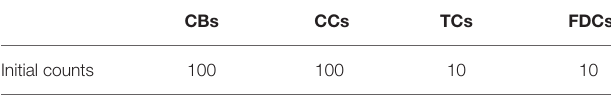
TABLE 2 | Initial conditions used in model simulations.